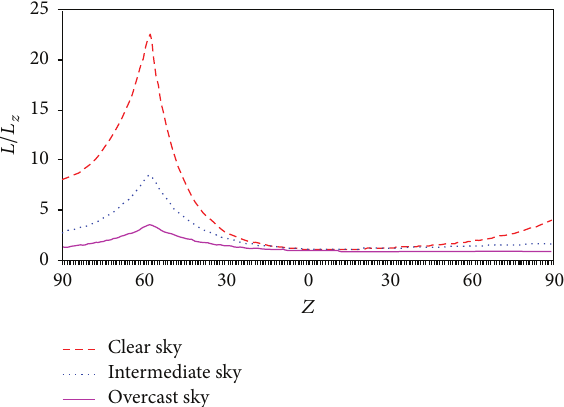
Figure 10: Variation of the relative sky luminance ( 𝐿/𝐿 𝑧 ) with the zenithangle 𝑍 forsolarzenithangle 𝑍 𝑠 = 58 ∘ underclearsky( 𝑛 = 0 ), intermediate sky ( 𝑛 = 0.5 ) and overcast sky ( 𝑛 = 1 ) versus 𝜒 for different values of Figure 8: The plot of 𝑓(𝜒)/𝑓(𝜒 ref solar zenith angle ( 𝑍 𝑠 ) for the case of cloud index 0 ≤ 𝑛 ≤ 0.1 . 𝜒 is the indicatrix angle of the sky subzone.